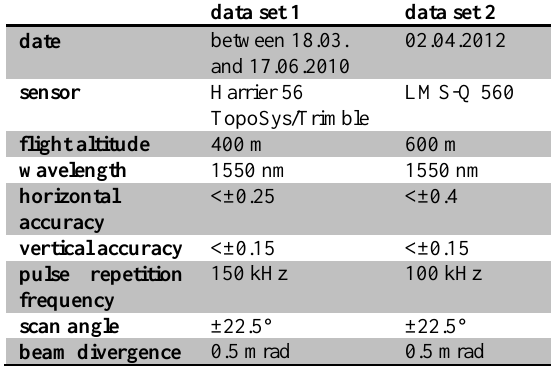
Table 1. Technical parameters of both flight